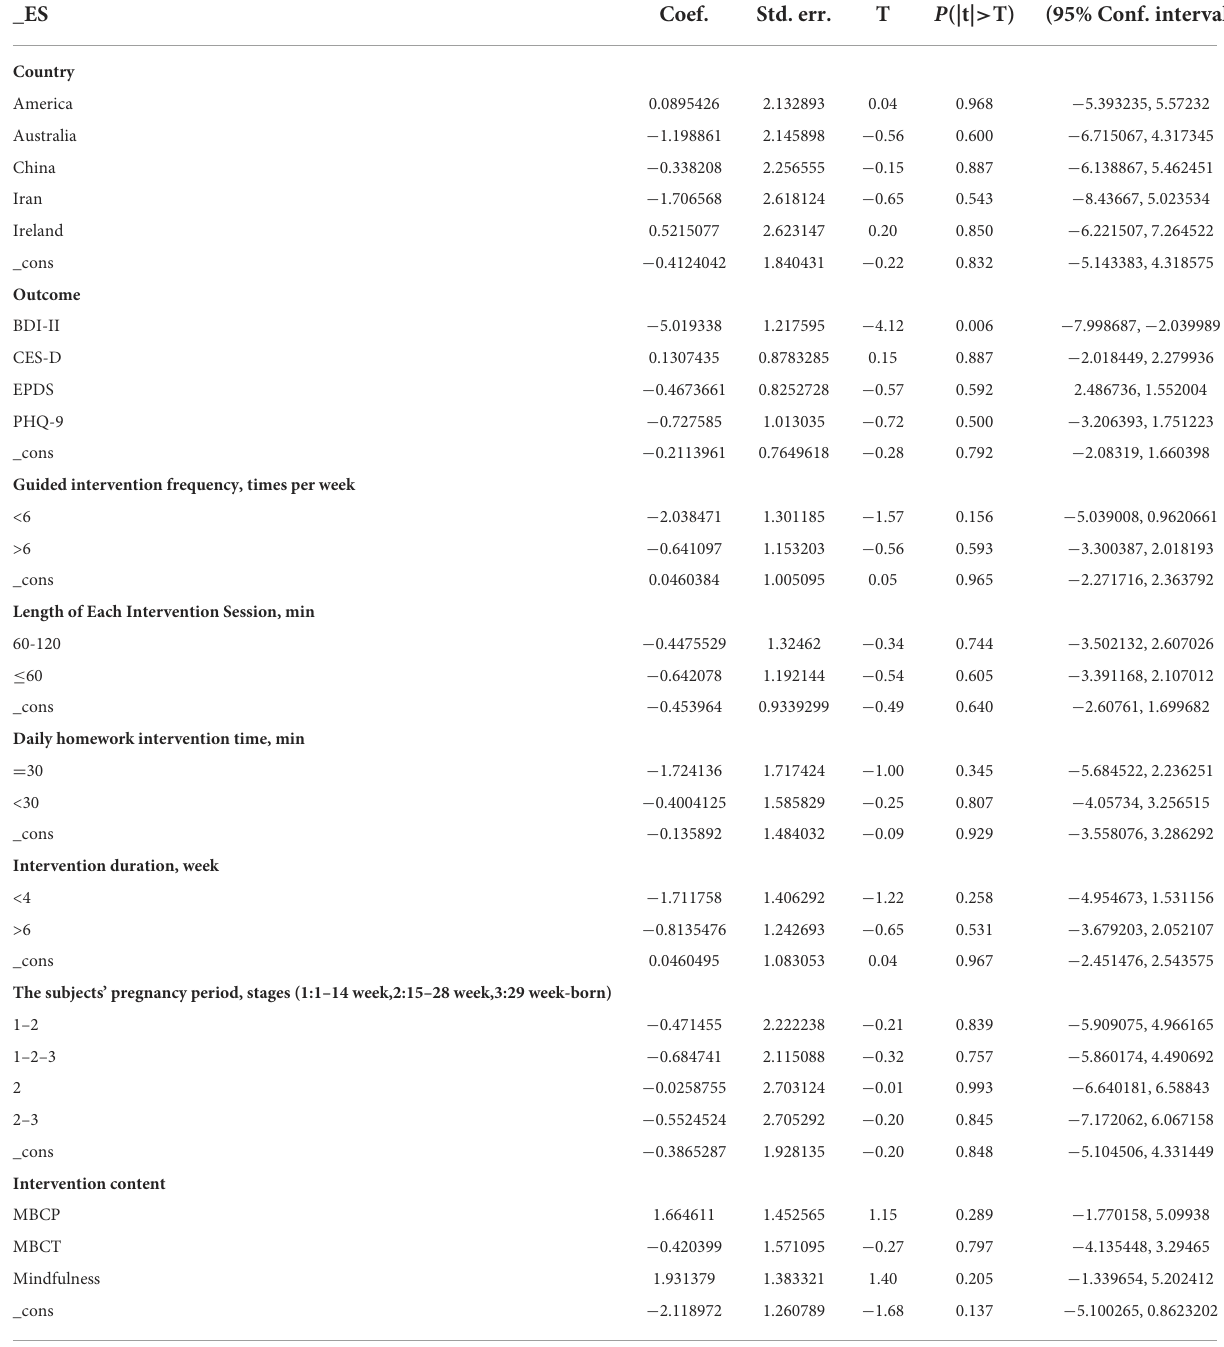
TABLE 2 Meta-regression analysis of heterogeneity among the effect of mindfulness meditation on depression during